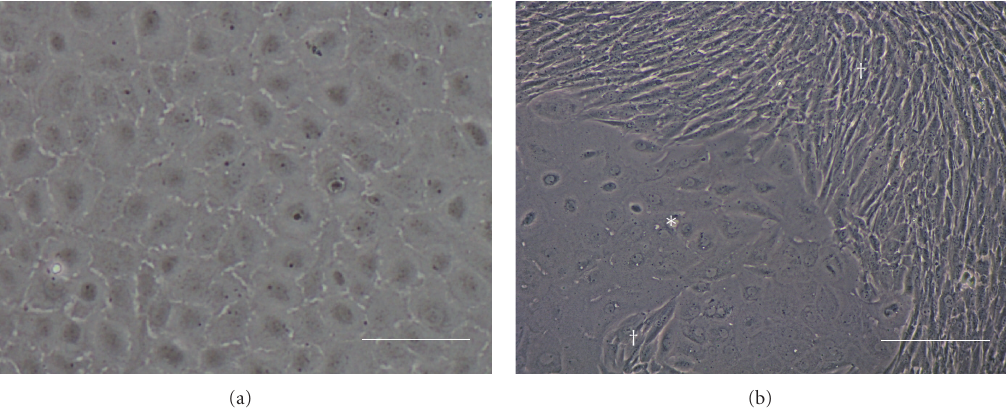
Figure 1: (a) Representative micrograph of a confluent homogeneous monolayer of successfully isolated human corneal endothelial cells at Day 14. (b) Representative micrograph of a failed isolation attempt resulting in stromal contamination at Day 7. The cellular boundary between the polygonal corneal endothelial cells ( ∗ ) and the confluent elongated corneal stromal fibroblasts ( † ) can be clearly defined (scale bars = 100 μ m).